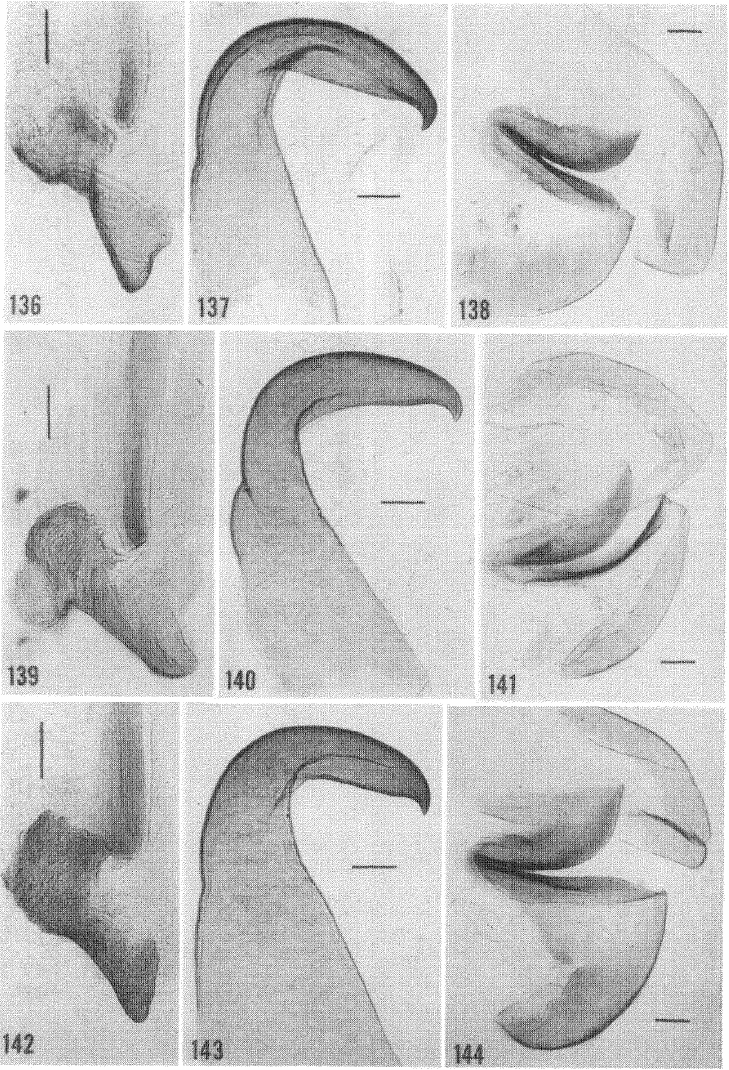
Figures 136-144. Male genital phallomeres of Gyrtotria latipennis. 136- 138. (62 BMNH). (from 8 shown in Fig. 37). 139-141. (995 L). Kitui (det. Prineis). 142-144. (151 ANSP). (from 8 shown in Fig. 101).. (scale 0.1